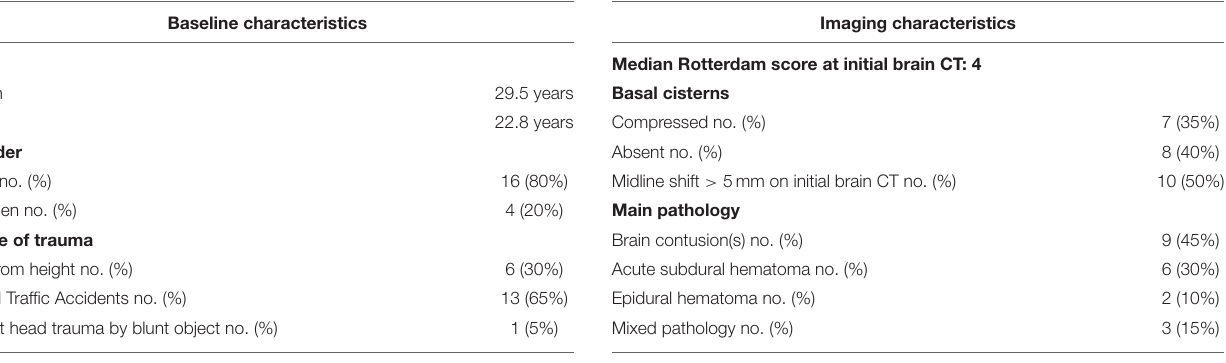
TABLE 3 | Imaging characteristics.